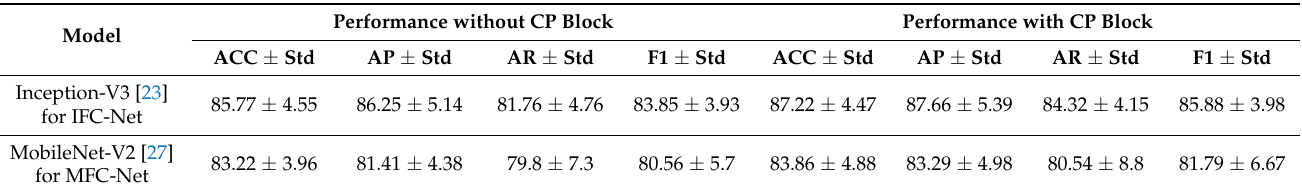
Table 1. Significance of using the CP block in IFC-Net and MFC-Net for the shoulder implant dataset. (CP: convolution pooling, ACC: accuracy, AP: average precision, AR: average recall, F1: F1.score, Std: standard deviation, unit: %).